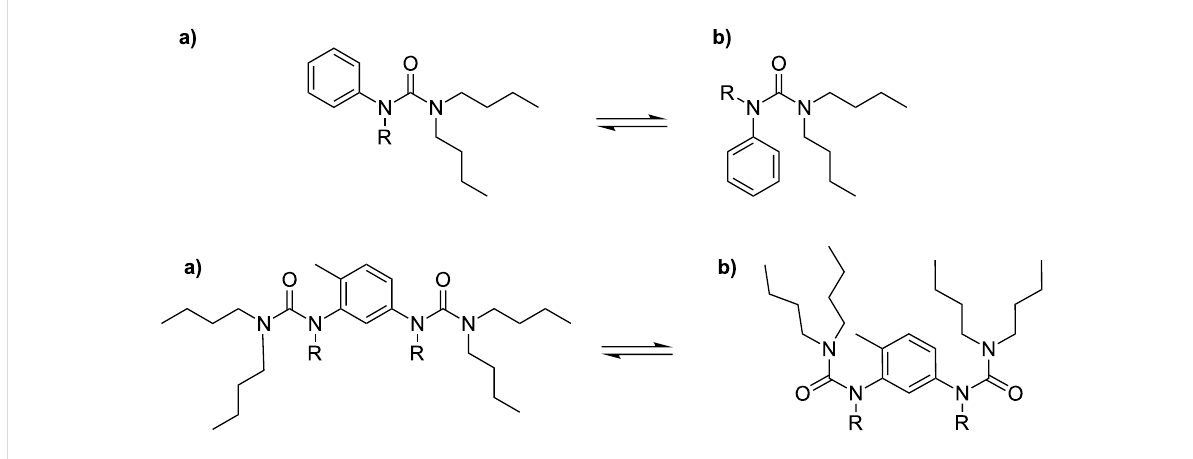
Figure 2: Substituted urea conformation. If R is alkyl, the most stable conformation is b); if R = H, the most stable conformation is a) [37].